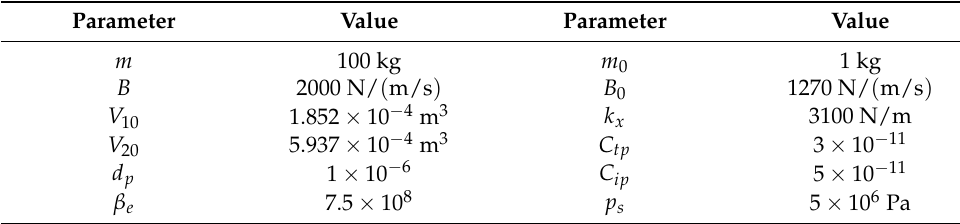
Table 1. Model parameters used in the Simulink.